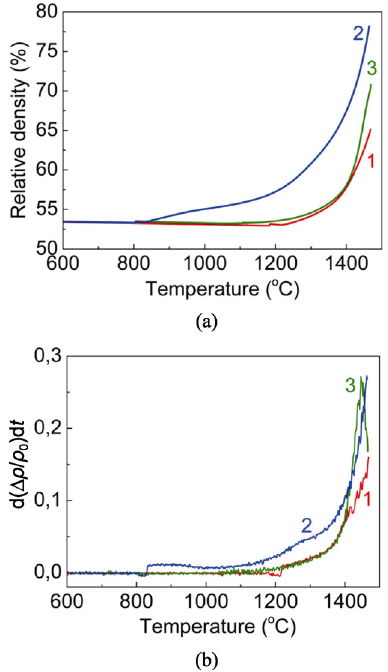
Fig. 4 Shrinkage curves (a) and shrinkage rates (b) of 0.86Y 2 O 3 ·0.09La 2 O 3 ·0.05Yb 2 O 3 powder mixtures prepared using Alpha-Micro (1), Alpha-Nano (2), and ITO-V (3) Y 2 O 3